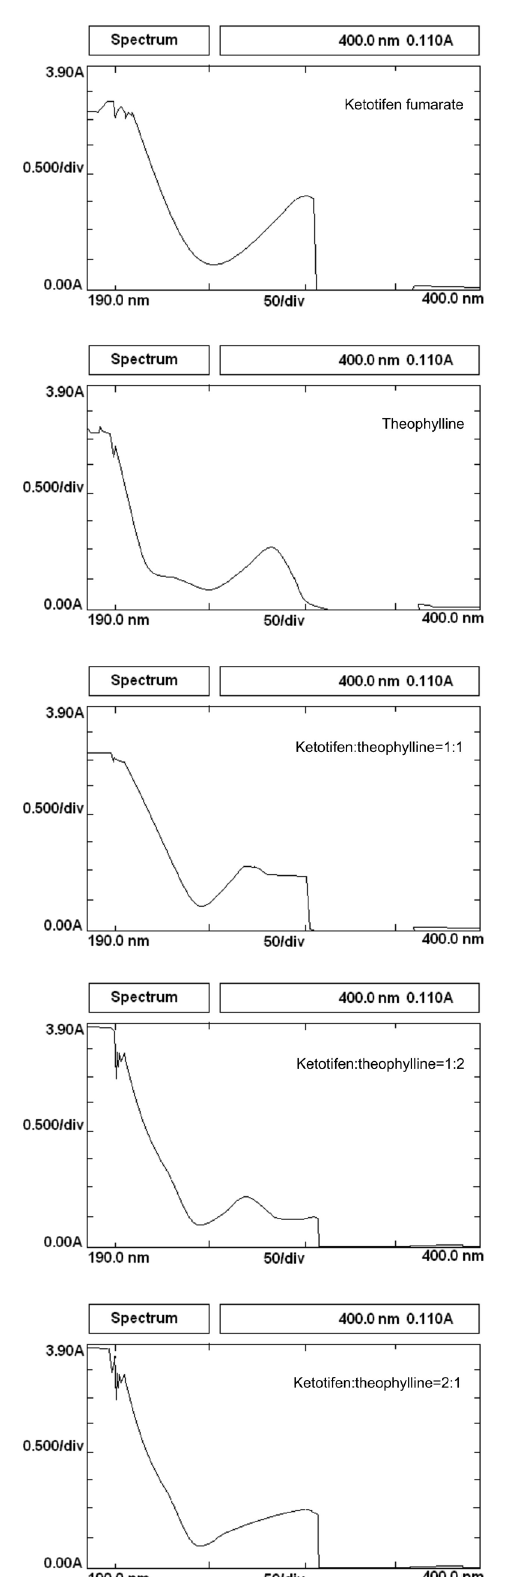
FIGURE 4 - Spectral studies of ketotifen fumarate and theophylline at pH 1.2. X axis: UV range; Y axis: absorbance.